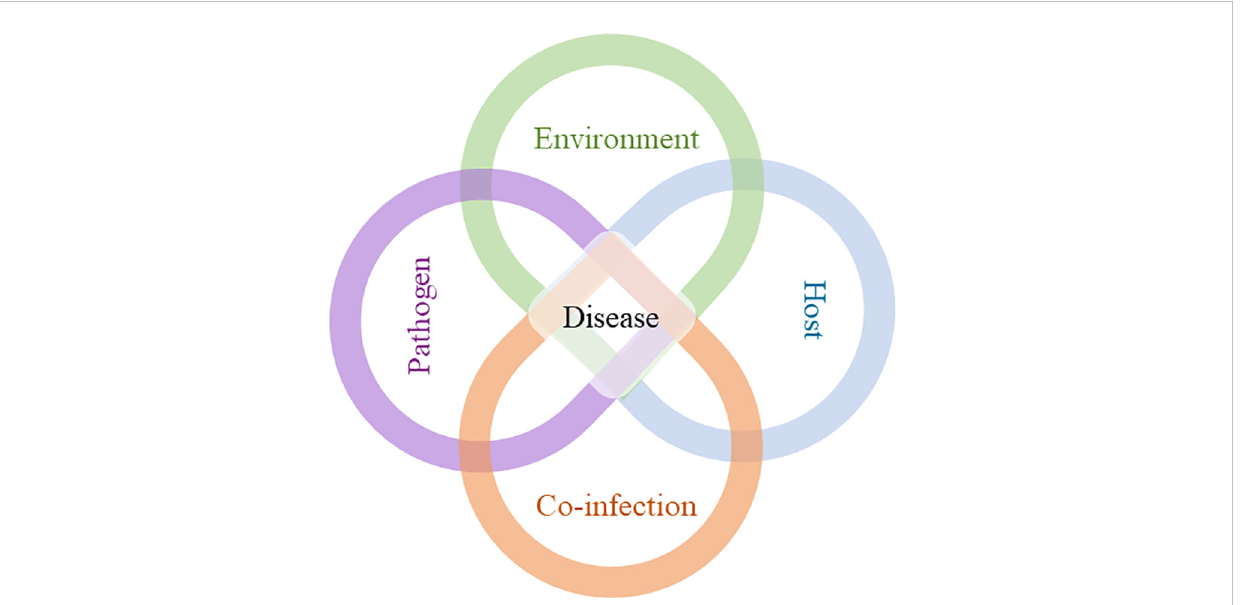
FIGURE 1 Development of a disease: interplay between environment, host, pathogen, and co-infection. The course of disease development cannot be suf fi ciently predicted by the interaction of host, pathogen and environment alone. Co-infection (s), along with the other factors, can interfere with the duration of infection, level of infectivity, clinical manifestations, and transmission, which can compromise disease